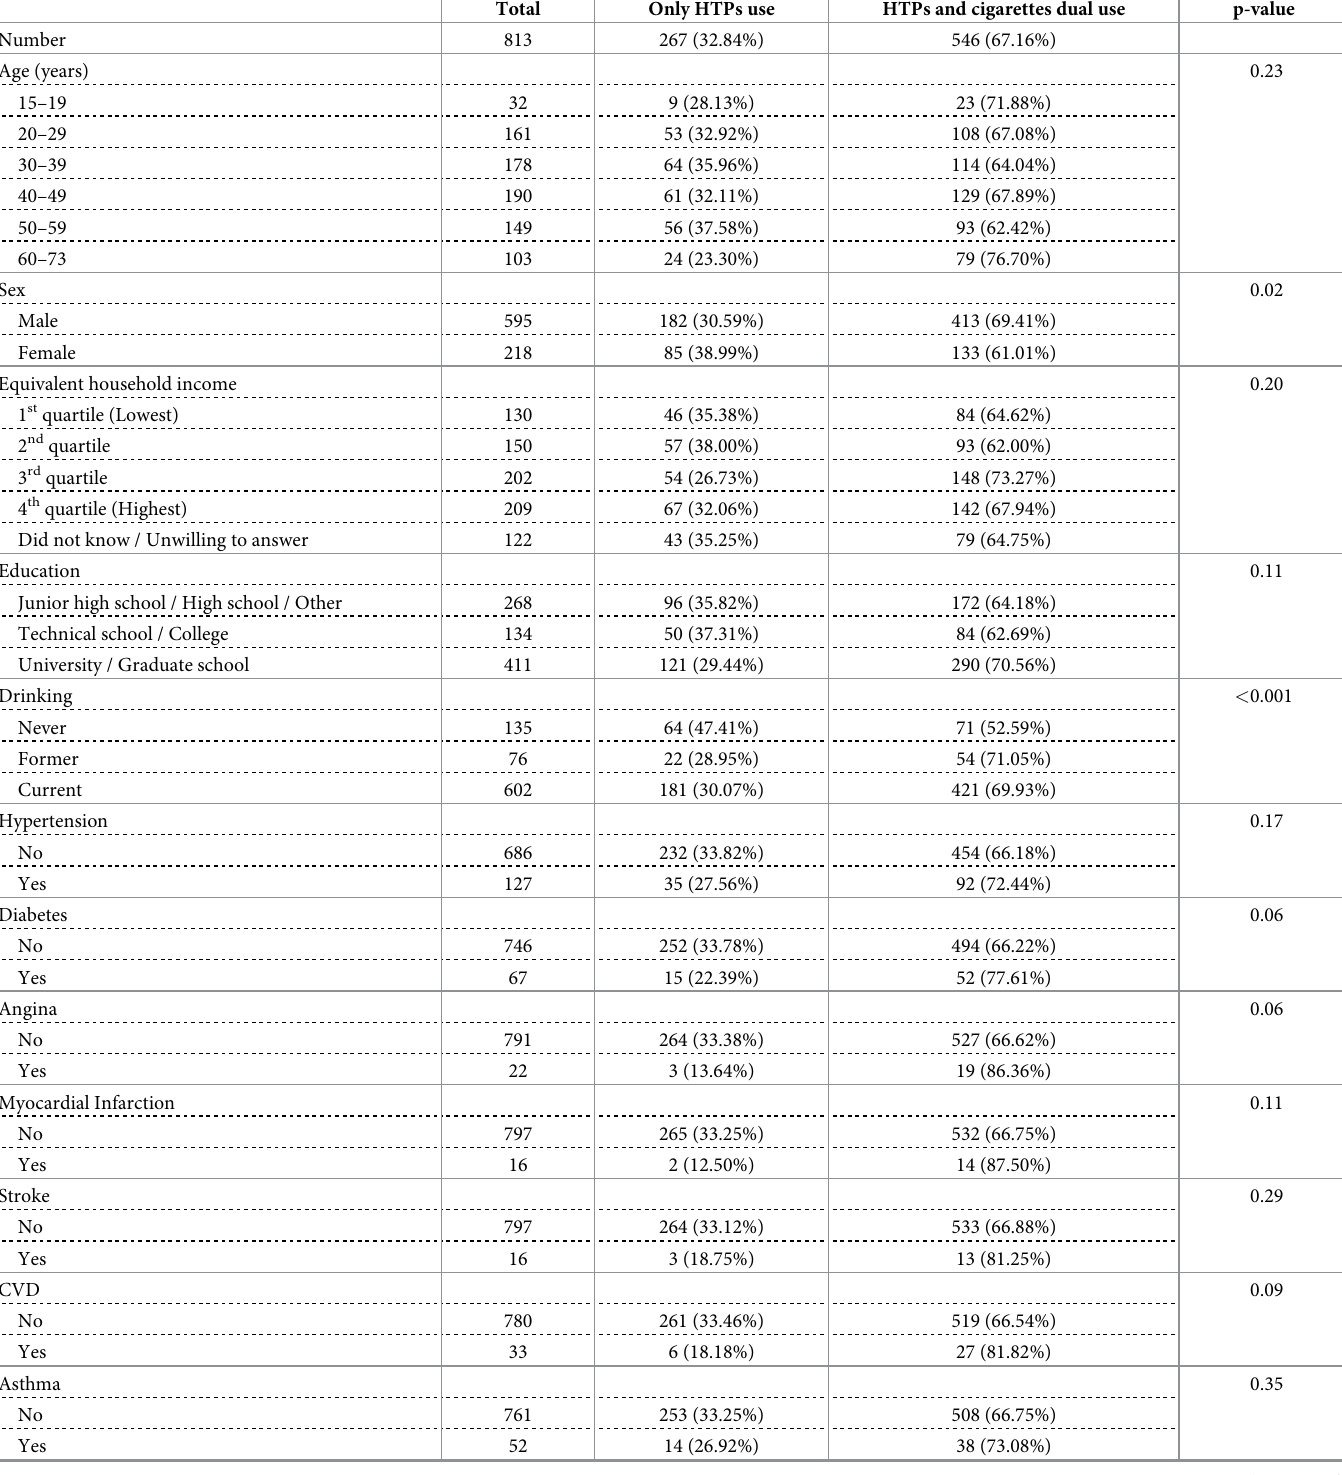
Table 2. Factors for dual use with cigarettes among all HTP